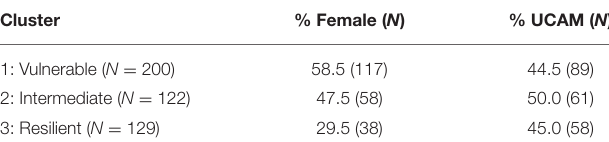
TABLE 1 | Distribution of sex and study site across clusters.